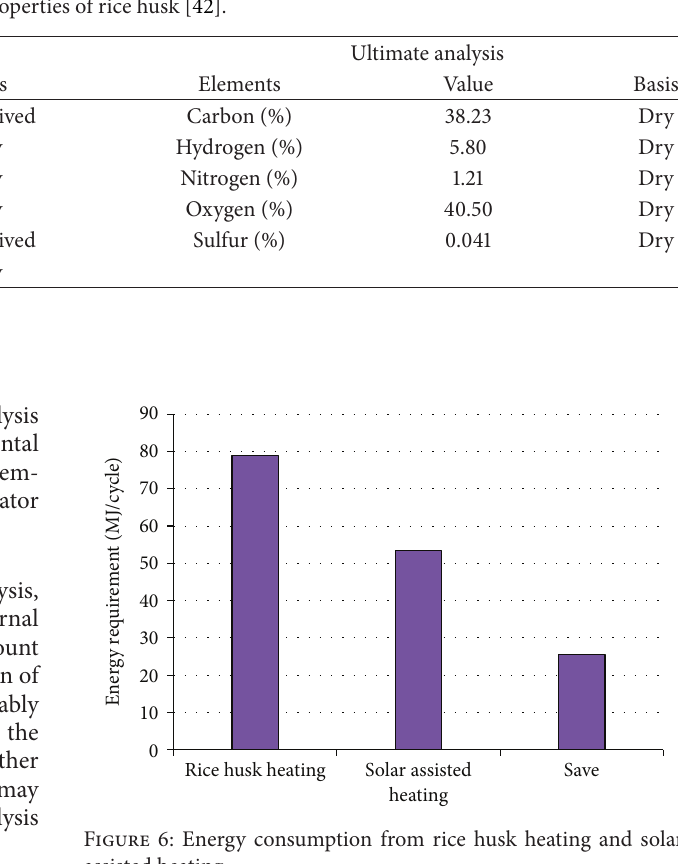
Table 3: Properties of rice husk [42].